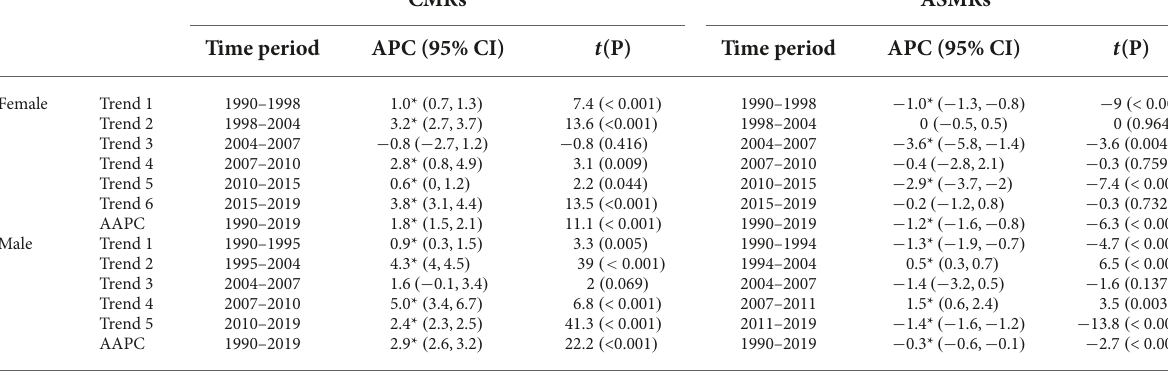
TABLE 3 Average and annual percent changes of PD mortality in China from 1990 to